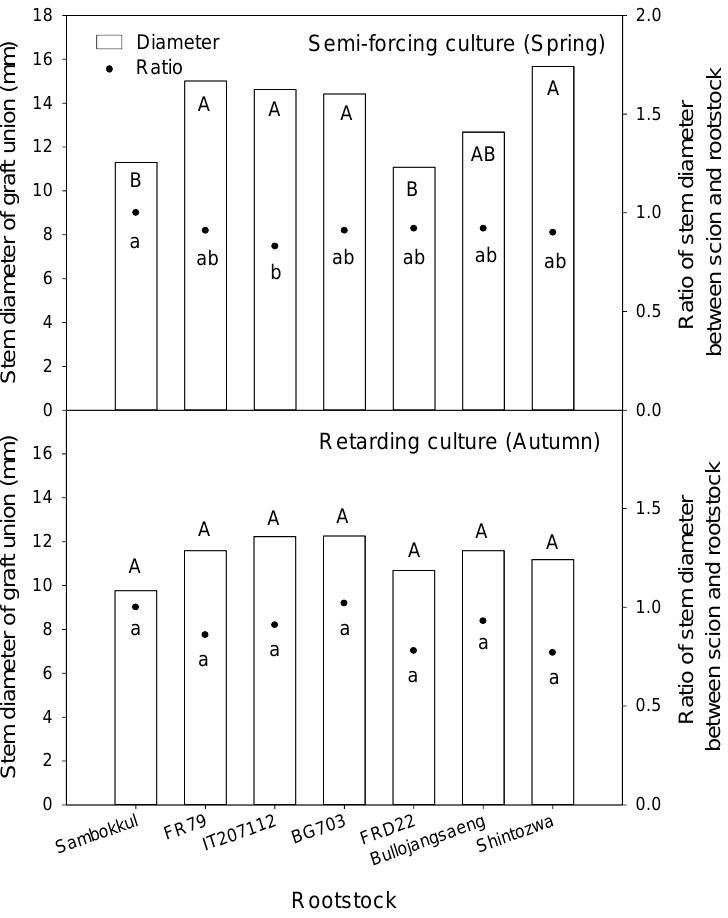
highest at 15.3 ◦ Brix, followed by the watermelon grafted onto ‘Bullojangsaeng’ at 12.6 ◦ Brix. Figure 6. The fruit set position and period for fruit set after transplanting influenced by bottle gourd The fruits grafted onto the other rootstocks were as low as 11 ◦ Brix. In retarding culture, rootstocks. Different letters indicated a significant difference within the column at the p ≤ 0.05 ac- the average fruit mass was 3.4–4.9 kg, which was smaller than those in the semi-forcing cording to Duncan’s multiple range test. culture. The TSS of fruits was in the range of 13–14 ◦ Brix. Among them, the watermelon grafted onto the ‘BG703’ was heavy and had a high TSS of 14.9 ◦ Brix.